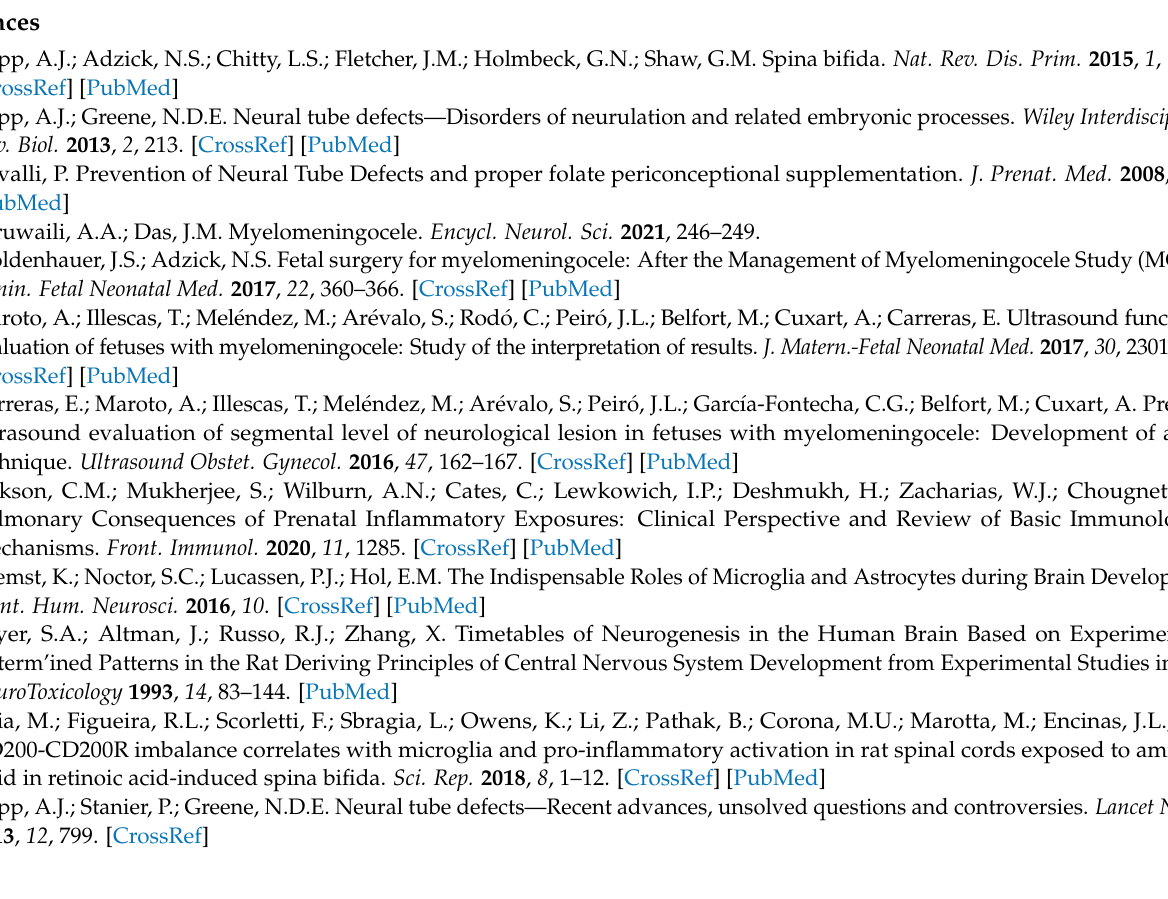
E17. Table S3: Top 25 upregulated and downregulated genes between MMC and control groups at E20. Table S4: Top 25 upregulated and downregulated genes between control and vehicle groups at E15. Table S5: Top 25 upregulated and downregulated genes between control and vehicle groups at E17. Table S6: Top 25 upregulated and downregulated genes between control and vehicle groups at E20. Graphical Abstract (created with